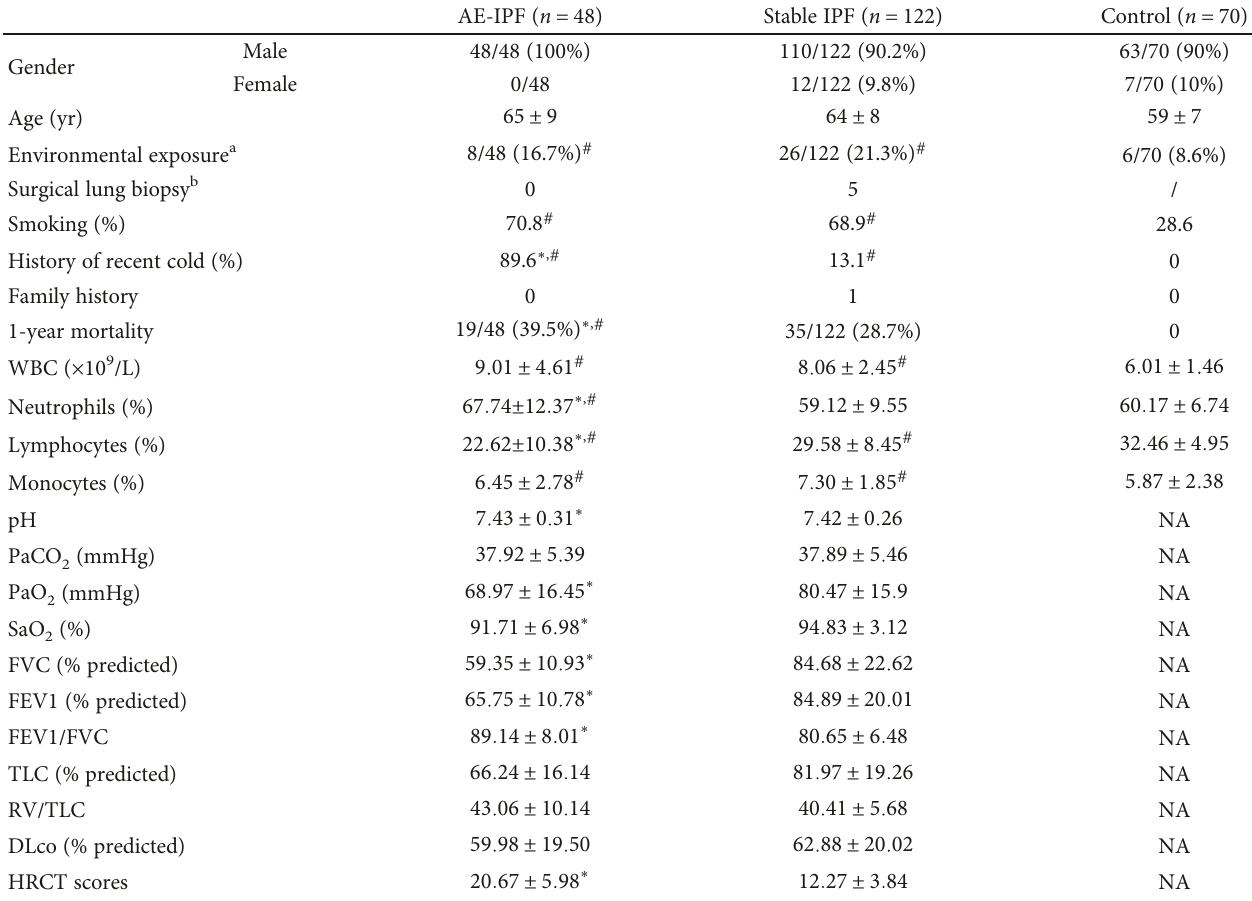
Table 2: Clinical